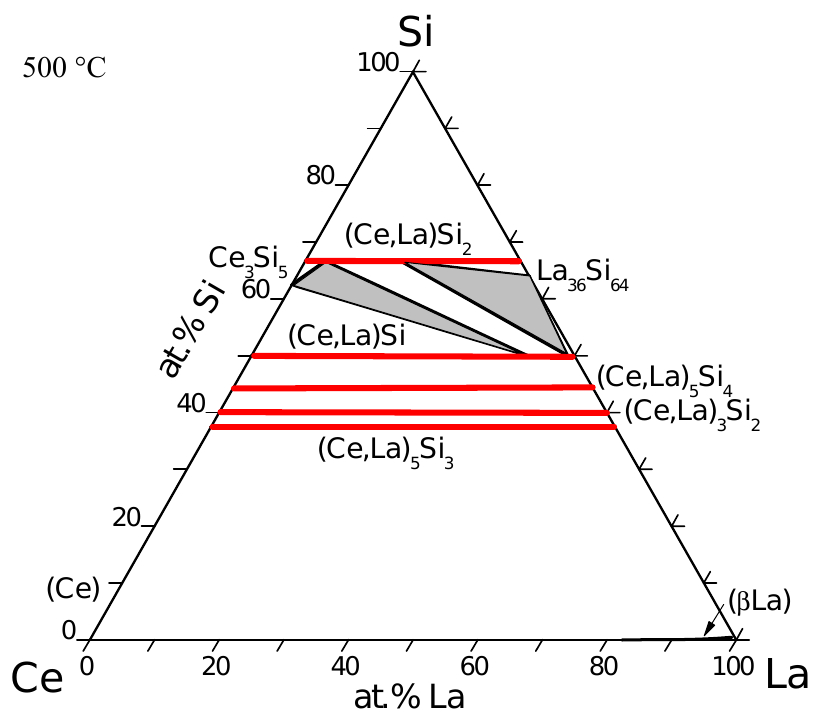
Figure 9. Calculated (predicted) isothermal Ce-La-Si phase diagram at 500 °C with five continuous solid